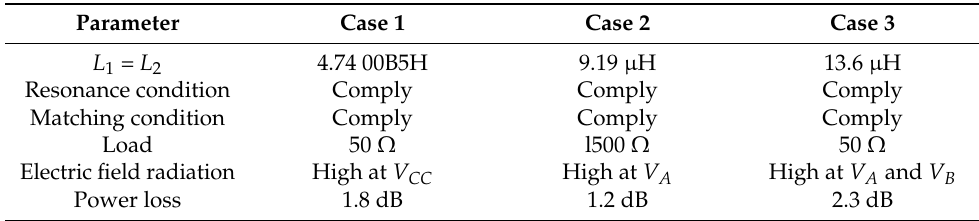
Table 2. Findings for the symmetric S-CPT based on the analysis